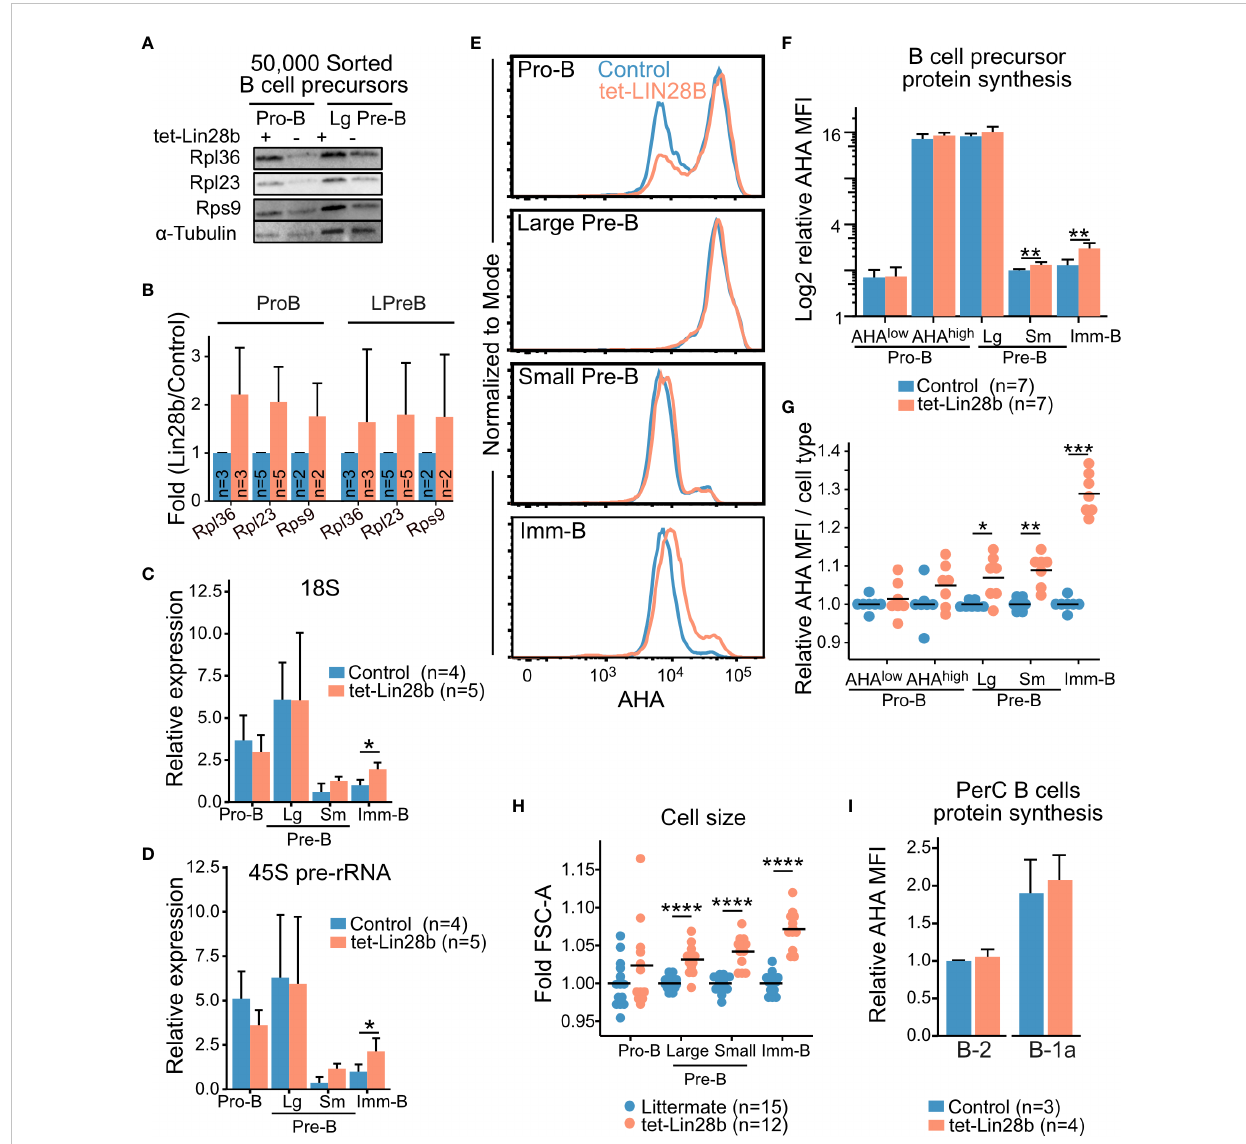
FIGURE 2 LIN28B enhances protein synthesis in small Pre-B and Imm-B cells (A) Representative western blot analysis for the indicated ribosomal proteins from 50,000 FACS sorted Pro-B and large Pre-B cells from adult tet-LIN28B or littermate control mice following 10 days of in vivo Dox induction. (B) Quanti fi cation of western blot data from 2-5 biological replicates and three separate experiments (See materials and methods). (C, D) qRT-PCR for 18S rRNA or 45S pre-rRNA from 50,000 FACS sorted adult B cell progenitors. Expression values were normalized relative to the littermate control Imm-B cells. Large and small Pre-B cells are indicated as Lg and Sm respectively. (E) Representative FACS histogram overlays of L-Azidohomoalanine (AHA) uptake, corresponding to their protein synthesis rates, in the indicated subsets from adult mice. (F, G) AHA median fl uorescence intensity (MFI) for indicated BM B cell precursor stage as shown in (E) . (F) Data is presented as relative values to one control small Pre-B cell subset for each experiment. (G) Data is normalized per cell type to one control sample for each experiment. (H) Measurement of FSC-A MFI. Data is normalized per cell type to one control sample for each experiment. (I) AHA MFI for the indicated, peritoneal cavity (PerC) B cell subsets, plotted relative to control B-2 values. Wilcox test was used to calculate p-values B – D , F , I . *p<0.05, **p<0.01, ***p<0.001, ****p<0.0001. Bars show mean, error bars show standard